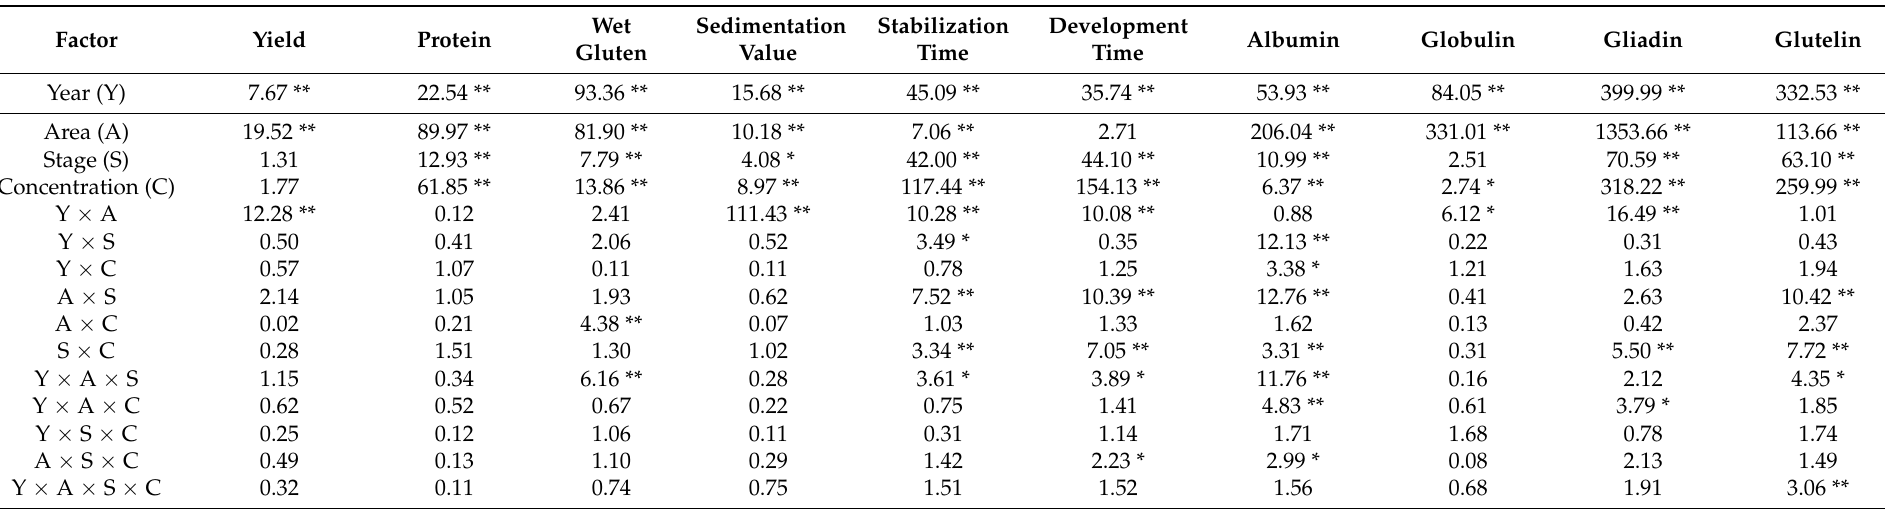
Table 2. Variance analysis of the effects of year, experimental site, and foliar application stage and concentration of potassium fertilizer on yield, protein and components, wet gluten, sedimentation value, and rheological properties of dough of wheat XN